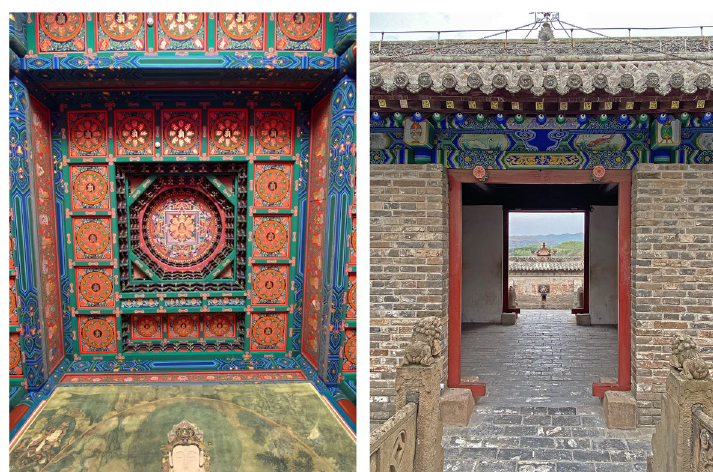
Fig. 1 Examples of typical caihua decoration on ceiling panels, wooden beams, and eaves, here apparently recently renovated. Left: Fahai Temple, Shijingshan District, Beijing. Right: Baiyunshan Temple complex, Jiaxian County, Yulin, Shaanxi Province (Source: the